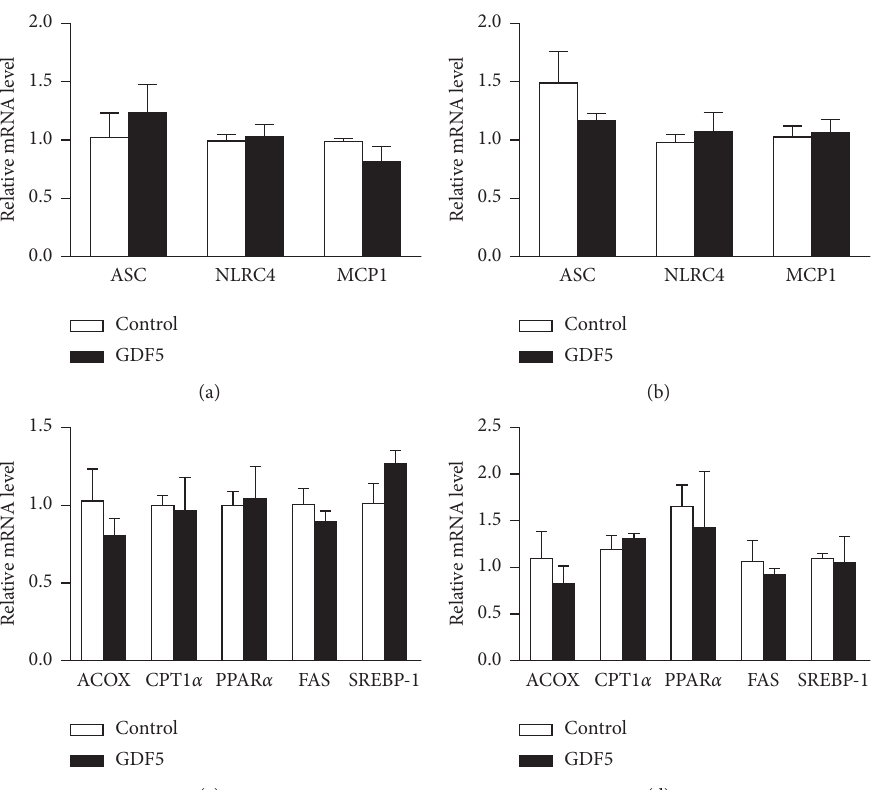
Figure 5: Normalized expression of NAFLD-related genes in LO2 cells. LO2 cells were transfected with a GDF5 overexpression lentivirus. (a) qPCR analysis of inflammation-related genes before FFA treatment. (b) qPCR analysis of inflammation-related genes after FFA treatment. (c) qPCR analysis of lipid metabolism-related genes before and (d) after FFA treatment. ( ∗ : P < 0 . 05; ∗∗ : P < 0 .